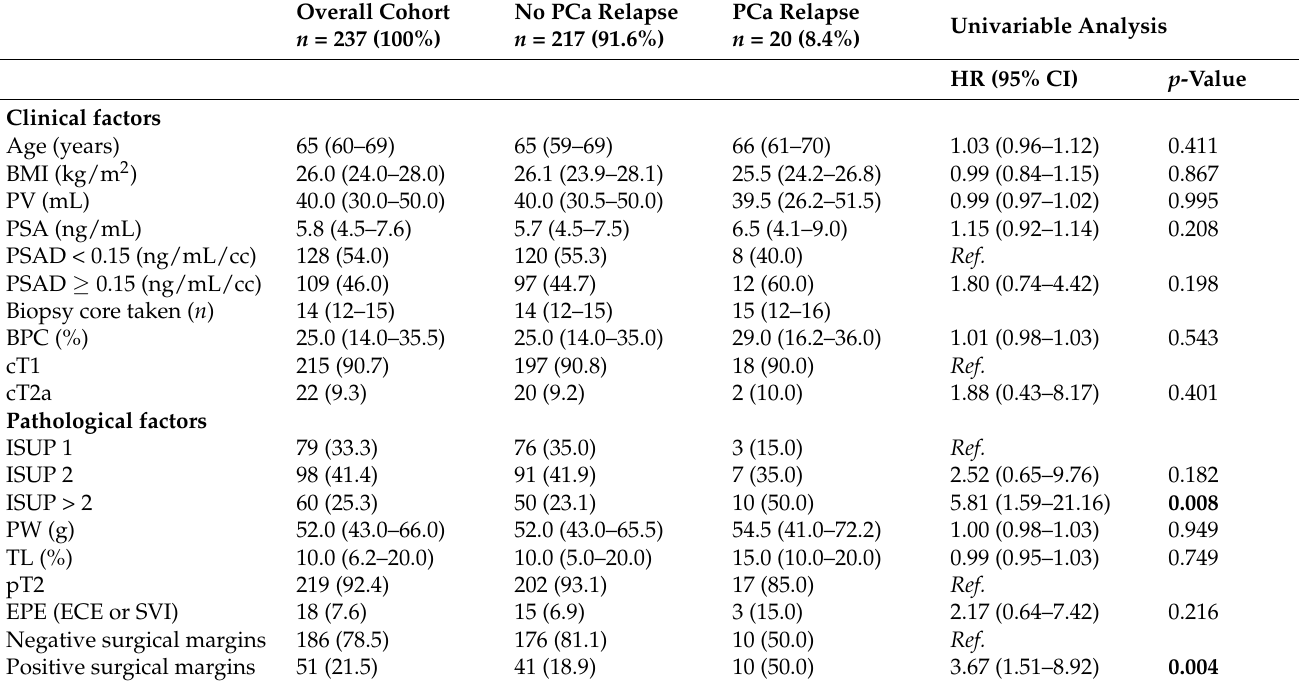
Table 1. Descriptive characteristics of 237 low-risk prostate cancer (PCa) patients stratified according to the presence of disease relapse after robot-assisted radical prostatectomy